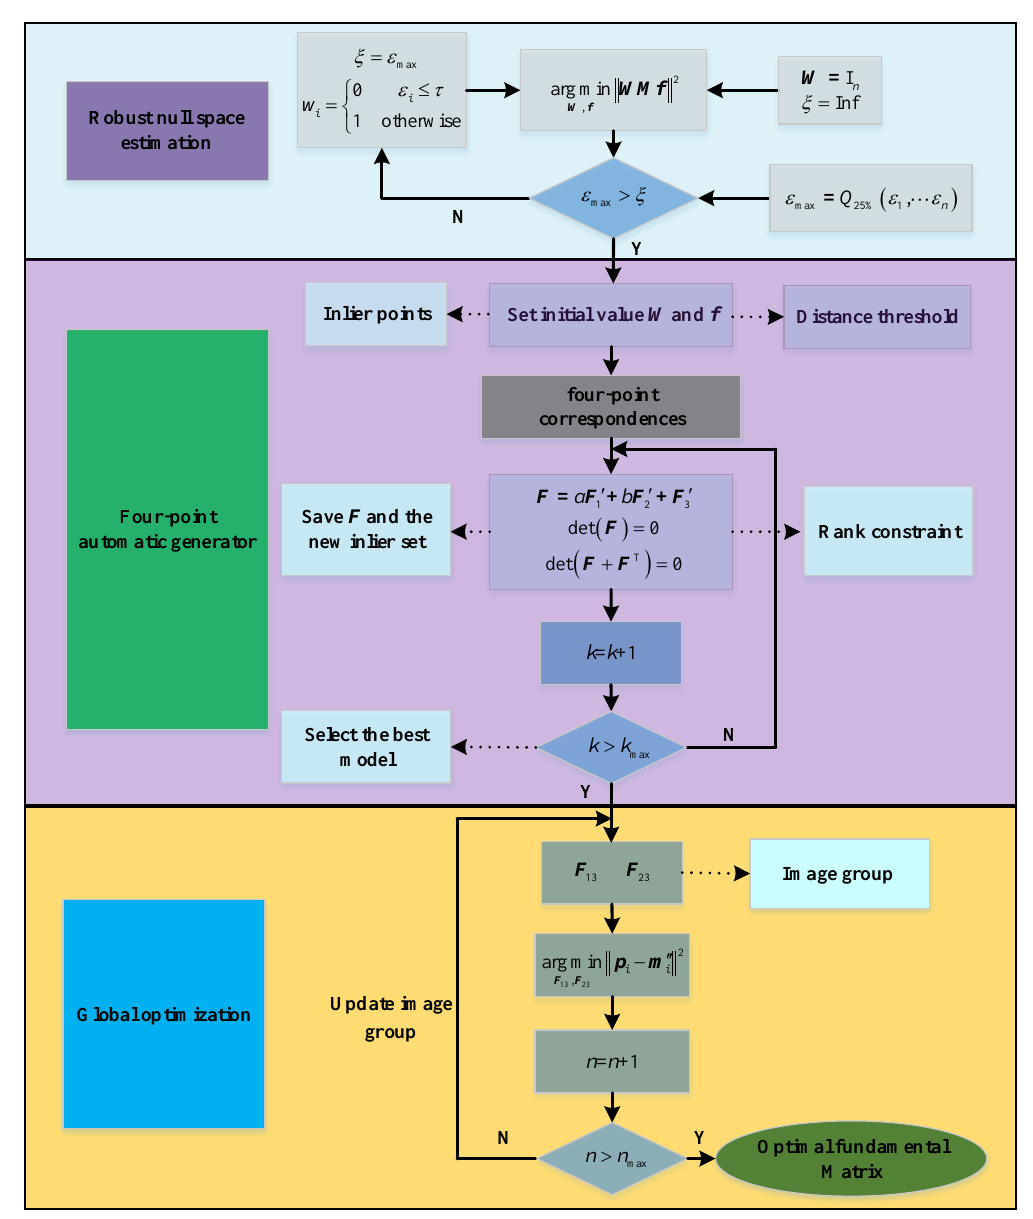
Figure 4. Flow chart of fundamental matrix estimation method.